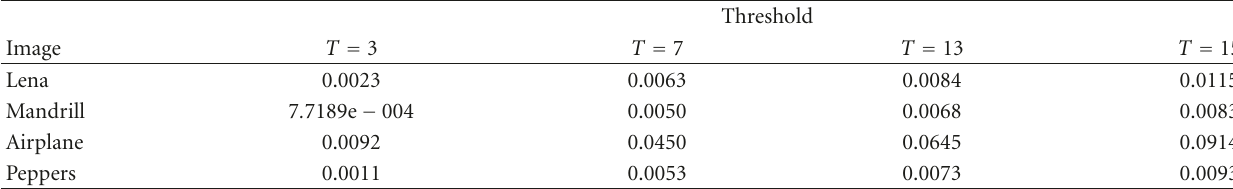
Table 5: KL divergence ( D KL ) of the